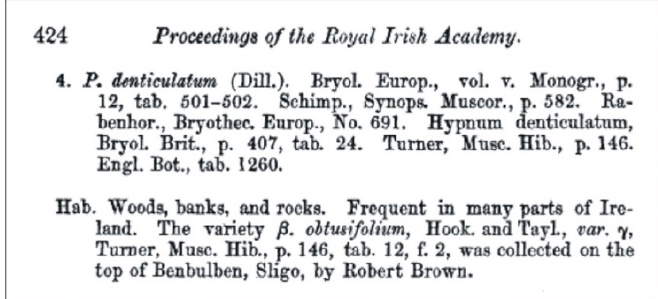
Figure 2. Description of Plagiothecium denticulatum var. obtusifolium [2].